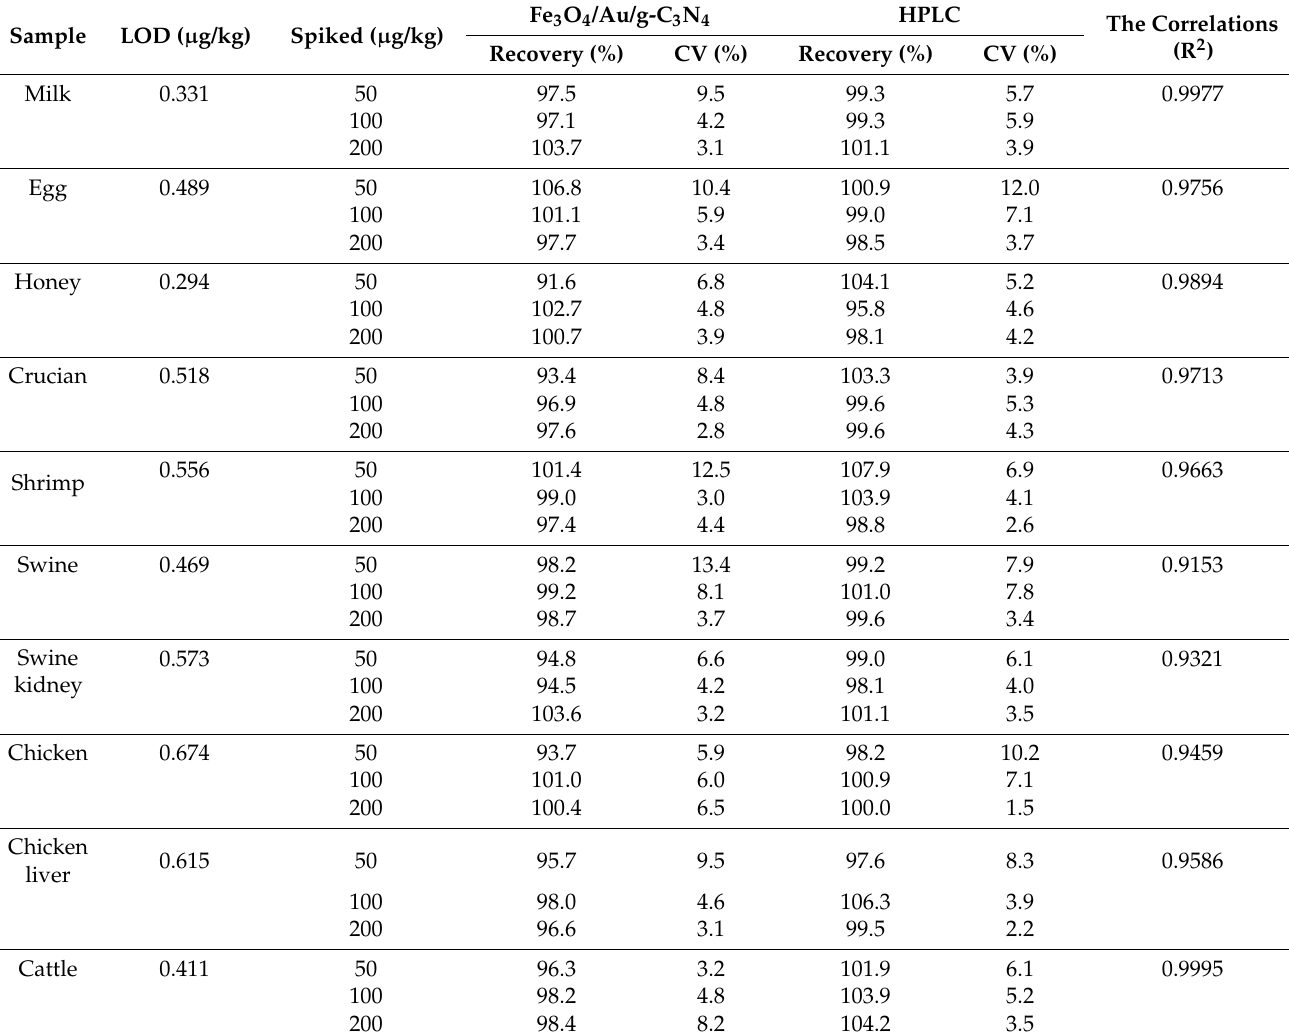
Table 1. LODs, Mean recoveries and coefficients of variation in spiked samples and correlations between the aptasensor and HPLC results ( n =